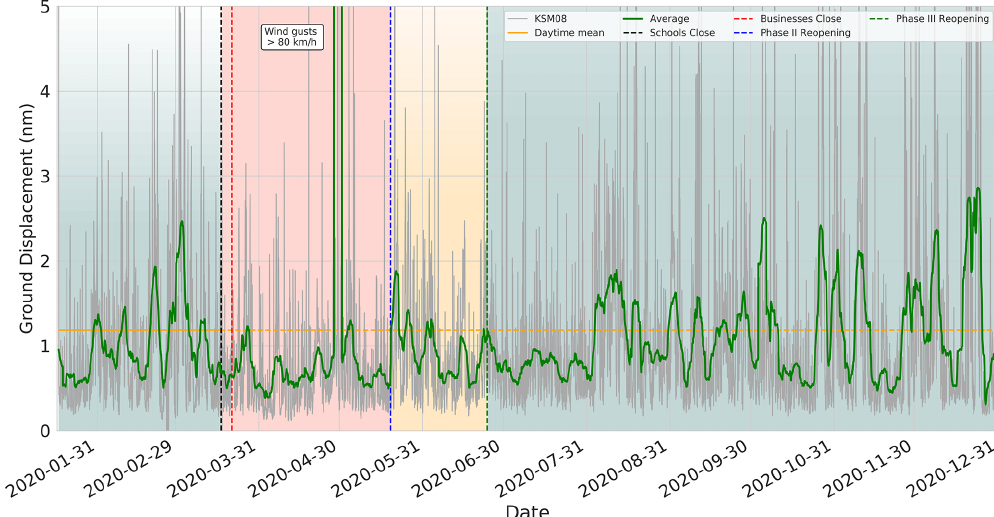
Figure 4. Filtered (4–14Hz) ambient seismic noise displayed as displacement from station KSM08 (vertical component) located within the KSMMA. Thirty minute average PPSD (dark grey) with rolling mean (window size = 92h) shown in green. The timing of different lockdown scenarios for British Columbia are shown as vertical dashed lines. Background colours represent different lockdown scenarios: green represents before and after lockdown scenarios, red is the first lockdown scenario with the closure of schools and restaurants and yellow is the second lockdown scenario where some businesses re-opened. A clear reduction in the average ground motion is observed following initial lockdown conditions in March 2020 and significant increases in average ground motion as lockdown measures are rescinded. Figure courtesy of codes developed by Thomas Lecocq and Fred